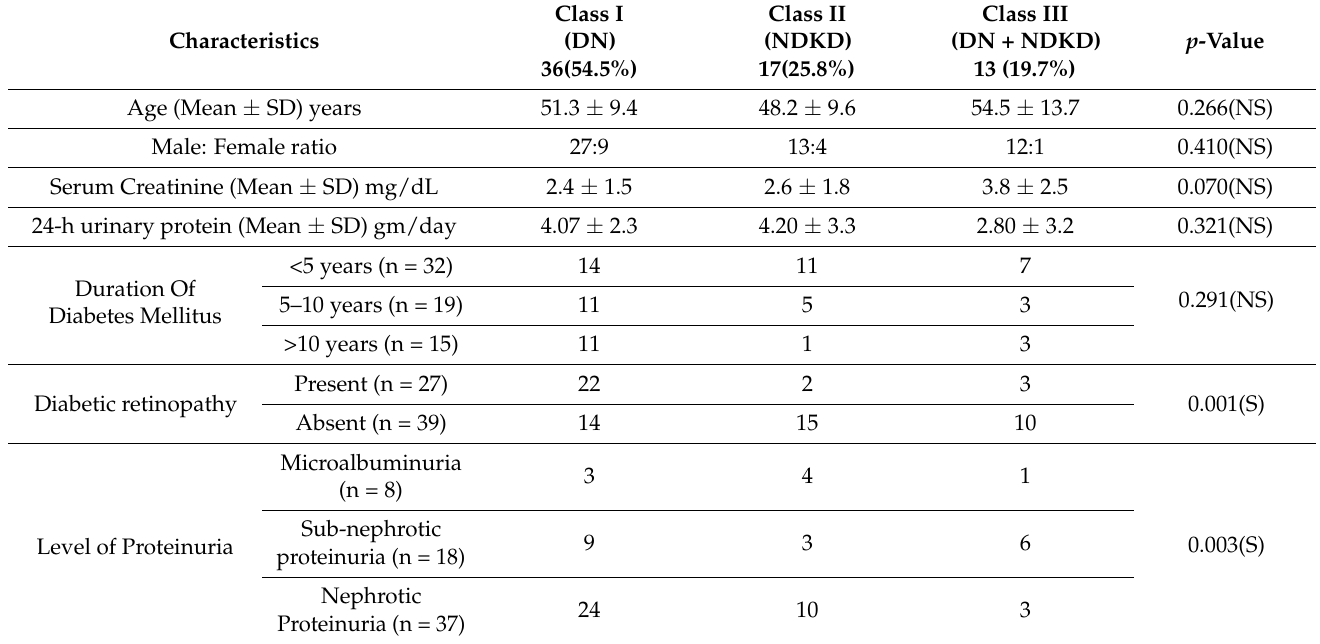
Table 2. Class-wise clinical characteristics of patients with type 2 diabetes mellitus (n = 66).